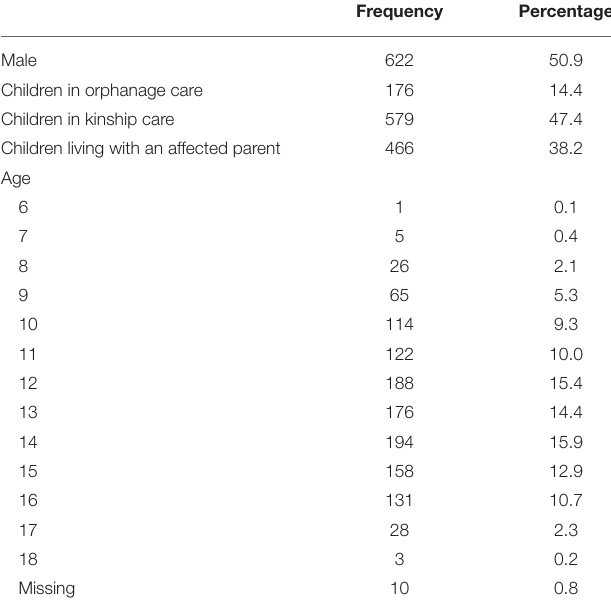
TABLE 1 | Child demographic